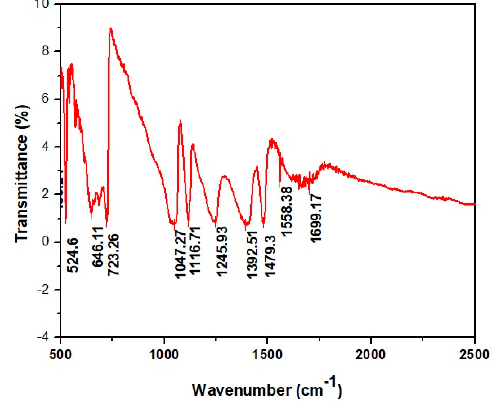
Figure 6. FT-IR Analysis of AgNPs .